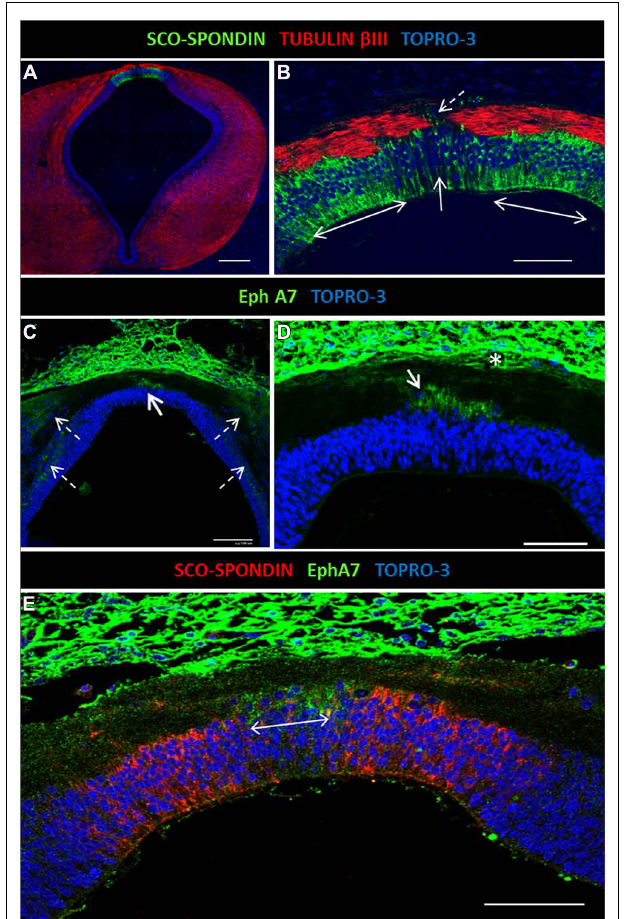
FIGURE 3 | Expression of EphA7 and SCO-spondin in diencephalic roof plate. (A) Double confocal immunofluorescence in HH30 brain section for SCO-spondin and tubulin β III showing the expression of SCO-spondin in the lateral diencephalic roof plate (doubles arrows in B ) and the depletion of this protein in the midline cells (continuous arrow in B ).The axons change the grade of fasciculation in the midline area, and some turn to the ipsilateral side (discontinuous arrow in B ). (C,D) Expression of EphA7 in the midline cells of the diencephalic roof plate (continuous arrow in C ) and in longitudinal columns parallel to the ventricular cavity (discontinuous arrows in C ). At the midline, EphA7 is found near the cell bodies of the roof plate cells (arrow in D ) and near the pial membrane (asterisk in D ). (E) Double immunohistochemistry for EphA7 and SCO-spondin showing the complementary expression of both proteins in the diencephalic roof plate, with the expression of EphA7 in the midline cells (double arrow) and SCO-spondin in the lateral area. Bars in (A) = 200 μ m; (C) = 100 μ m; and in (B,D,E) = 50 μ